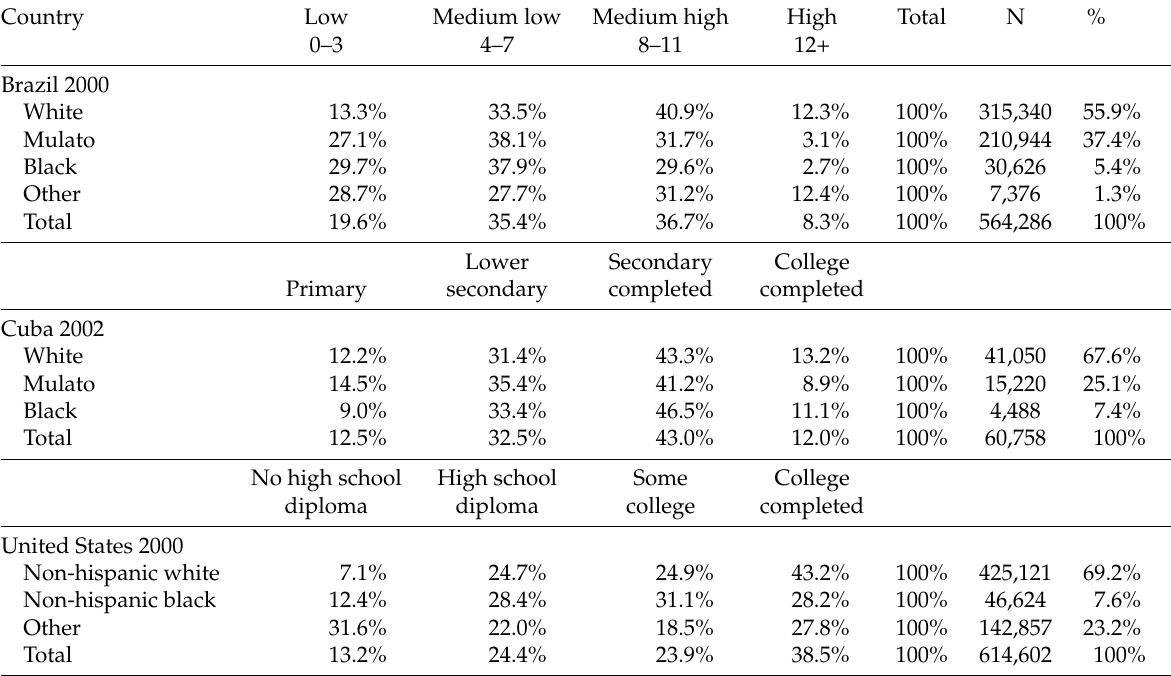
Table 1: Educational attainment by race; women in unions aged 25 to 34 (Brazil 2000, Cuba 2002, and the United States